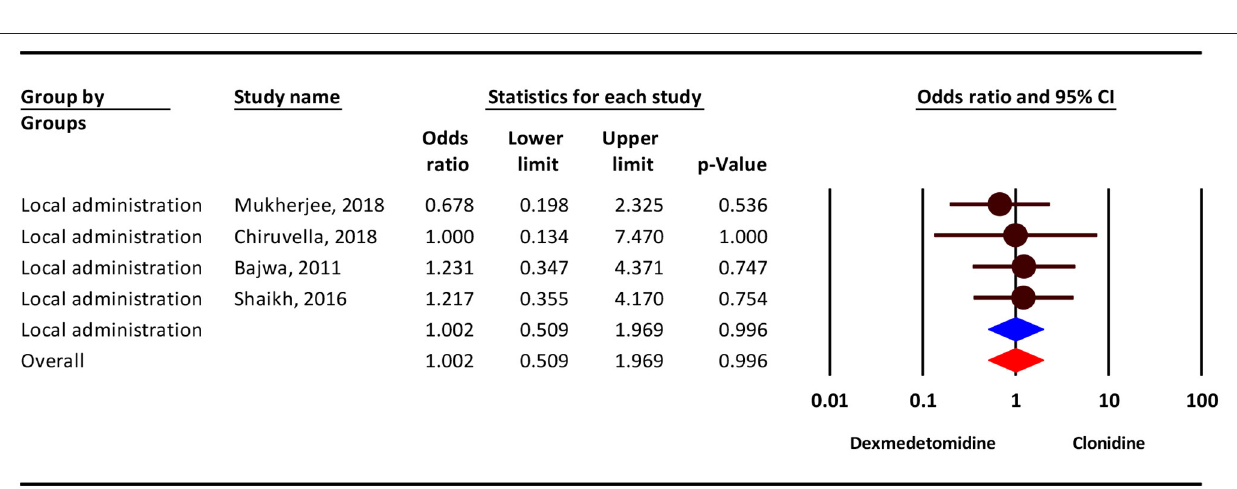
FIGURE 6 | The odds ratio for the risk of dry mouth as an adverse event associated with the adjuvant use of dexmedetomidine and clonidine in local